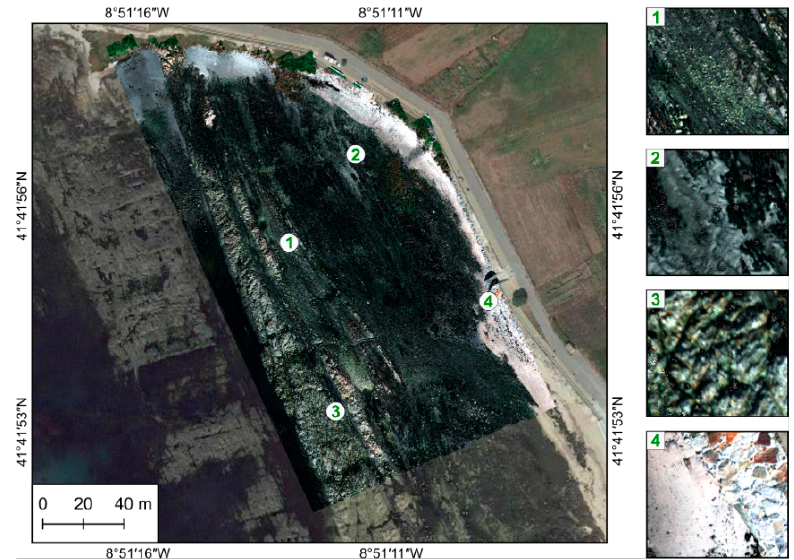
Figure 20. Viana area: overview of the final hyperspectral mosaic and close-ups to show the good alignment achieved ( 1 – 4 ). No misalignments are visible.